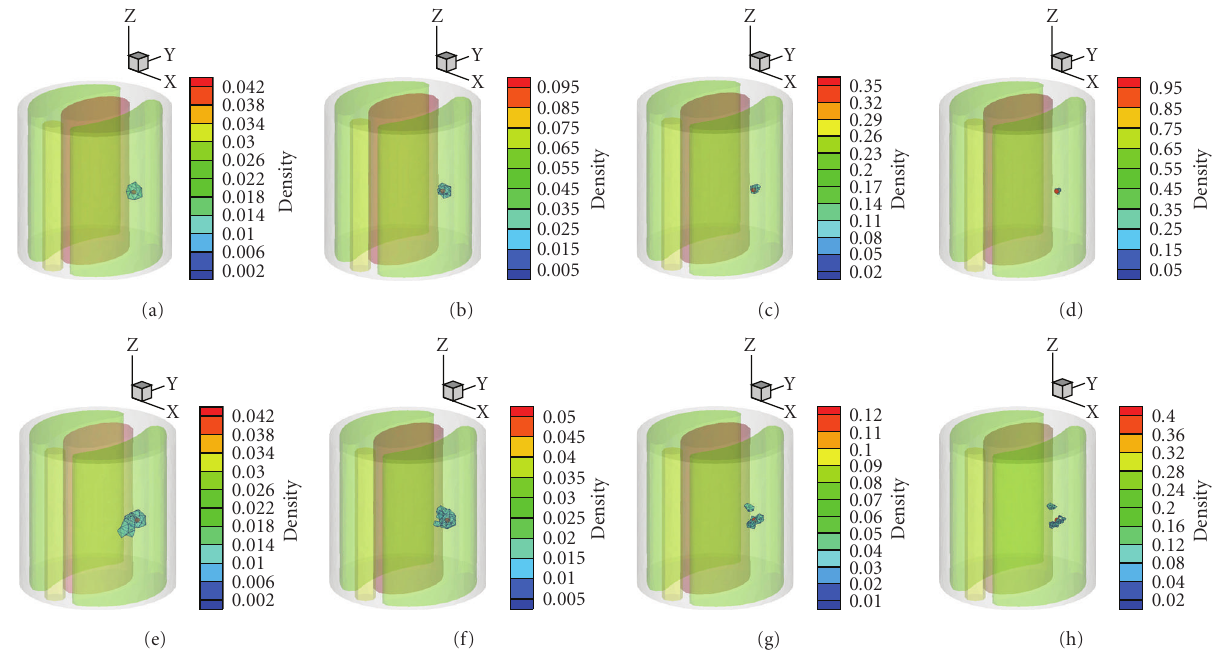
Figure 2: Reconstruction results in single source case on di ff erent mesh level, where the actual source is drawn as a red sphere. (a)–(d) are the isosurface of the reconstructed density by regularization from initial level to the final level, respectively. (e)–(h) are the corresponding results by regularization method, with a threshold of 50% of the maximum value.